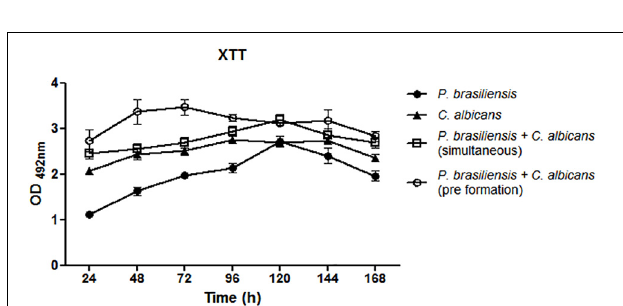
FIGURE 1 | Quantification of mono and dual-species biofilm biomass by crystal violet methodology. Co-cultivated dual-species biofilms and dual-species biofilms formed by the addition of P. brasiliensis inoculum to preformed 12 h C. albicans biofilms. Three independent experiments with six replicates each were performed. Error bars indicate the standard error. Statistical significances were calculated by using analysis of variance (ANOVA) followed by Bonferroni test.